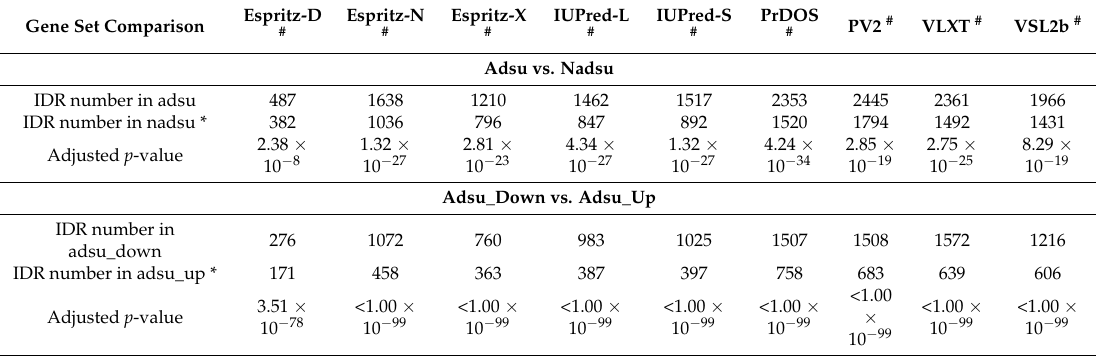
Table 1. Intrinsically disordered regions are enriched in proteins encoded by down-regulated genes in lymphoma cells upon adherence to stromal